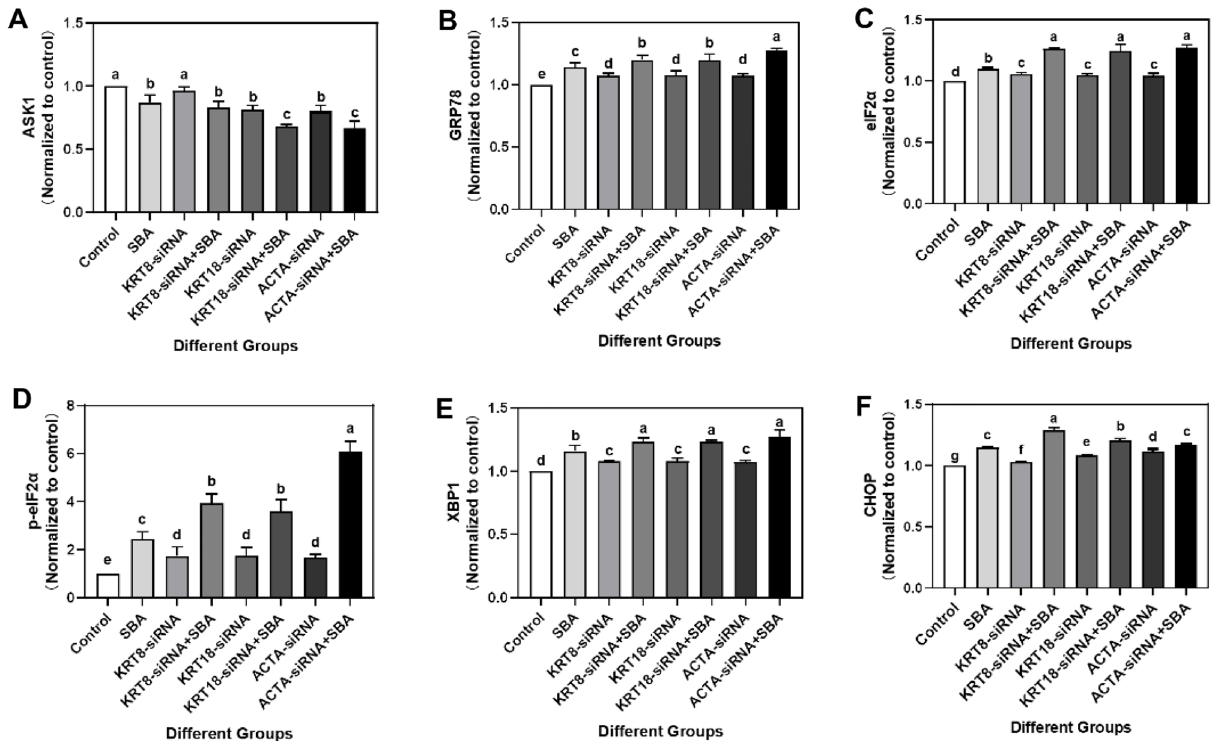
Figure 17. ( A – F ) Analysis of protein expression of endoplasmic reticulum stress in different treatment groups. The protein expressions in different treatments were obtained from the western blot represented. ( A ) Protein expression of ASK1; ( B ) Protein expression of GRP78; ( C ) Protein expression of eIF2α; ( D ) Protein expression of p-eIF2α; ( E ) Protein expression of XBP-1; and ( F ) Protein expression of CHOP. Data were analyzed using Bandscan software. Each column represents the mean ± SEM of three independent experiments. Different lowercase letters indicate the significance of differences between different treatment groups ( p <